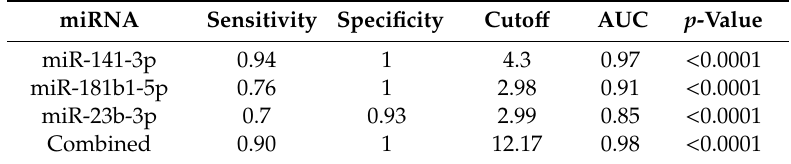
Table 3. ROC analysis of miRNAs in TNBC patients compared with other molecular subtypes of breast cancer.